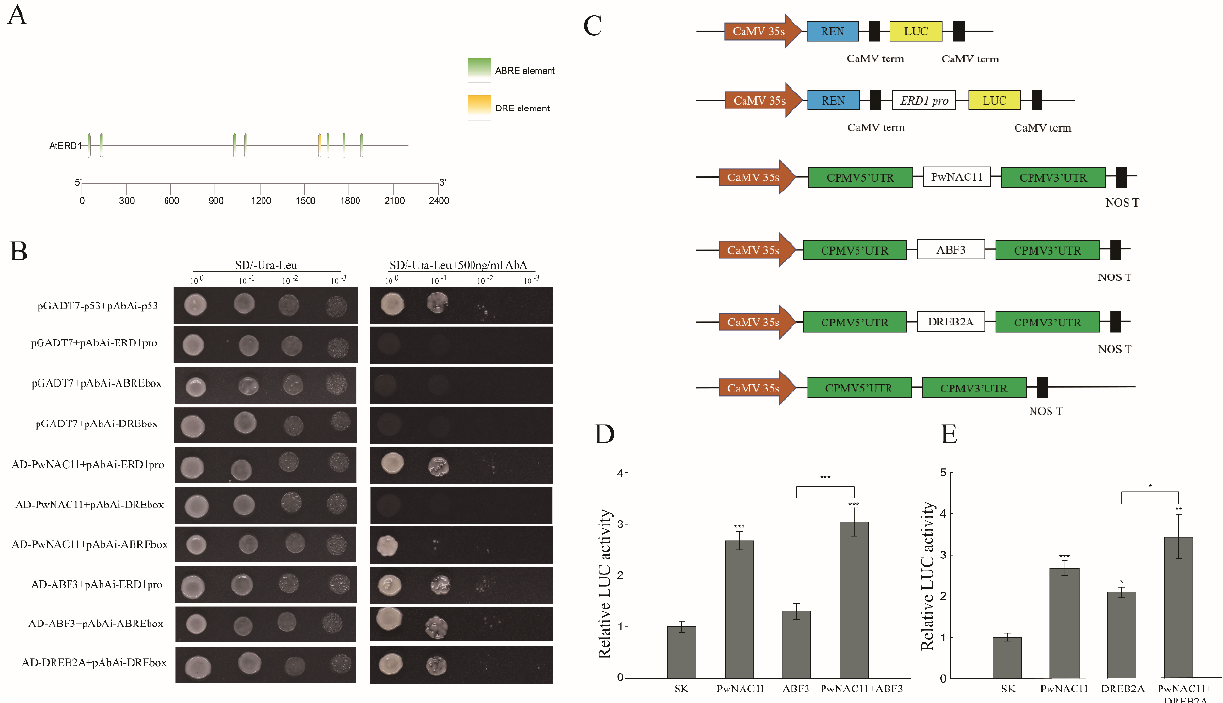
Figure 8. PwNAC11 and ABF3 cooperatively activates ERD1 transcription. ( A ) Diagram of the ERD1 promoter. The seven ABREs detected in ERD1 promoter are indicated in green and one DRE is marked in yellow. ( B ) Yeast one-hybrid assays for the interaction of PwNAC11 with ERD1 promoter, ABRE and DRE element. Aureobasidin A (AbA) of 500ng/mL was used to inhibit autoactivation. pGADT7-p53 and pAbAi-p53 were used as positive control. Empty PGADT7 was used as negative control. ( C ) Sketch map of the double-effector and reporter plasmids in dual-luciferase reporter assay. ( D ) Dual-luciferase assays for PwNAC11 and ABF3 interactions. ( E ) Dual-luciferase assays for PwNAC11 and DREB2A. The data are represented as means ± standard error from three independent replications. The grey lines indicate the comparisons and asterisks indicate significant differences compared with SK (* p < 0.05; ** p < 0.01; *** p < 0.001).